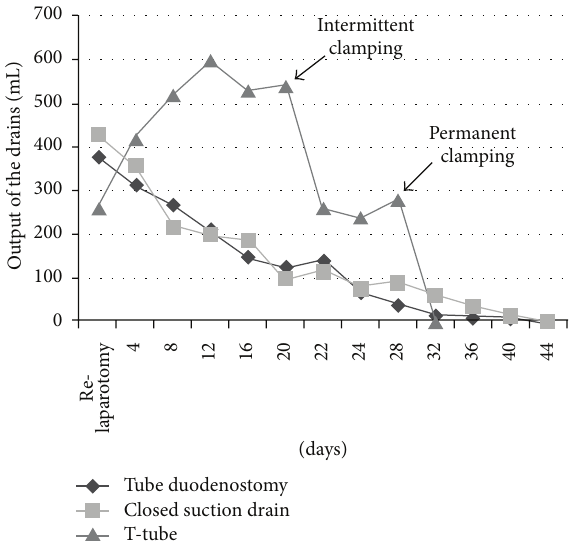
Figure 4: Comparison of mean daily outputs of the tube duodenos- tomy, T-tube, and closed suction drain near the tube duodenostomy. Thelackofomentalpatchisdepictedbythehighoutputoftheclosed suction drain which reflects duodenal leak from the side of the tube